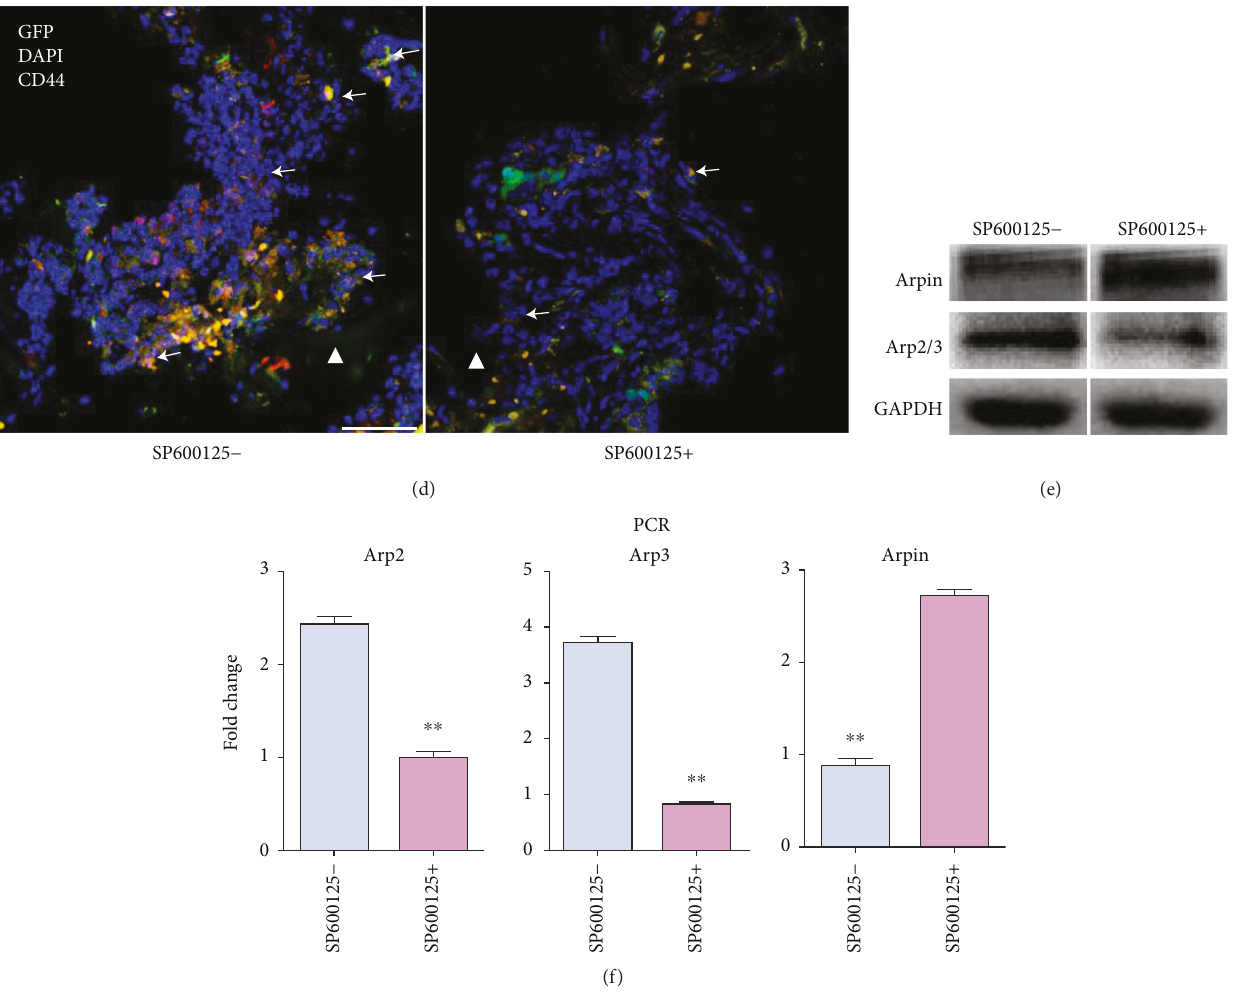
Figure 5: JNK served as an e ff ector downstream of SDF-1/CXCR4 in the migration of bone marrow (BM) CD44 + cells towards tissue- engineered constructs (TECs). (a) Comparison of phosphorylated JNK (p-JNK), ERK (p-ERK), and P38 (p-P38) expression in BM cells after CXCR4 blockade. After migration stopped, BM cells were collected and analyzed by western blot. (b) Representative images of cell migration towards SDF-1. The quanti fi cation of migrated BM cells is shown as a bar graph ( n = 5 ). ∗∗ P < 0 01 . (c) FACS analysis of the proportions of CD44 + cells in peripheral blood (PB). The quanti fi cation comparison is shown as a bar graph ( n = 3 ). ∗∗ P < 0 01 . (d) Representative images of in vivo migration of GFP + /CD44 + cells towards TECs. The introduction of SP600125 signi fi cantly reduced the recruitment of GFP + /CD44 + cells. White triangle, implant area; white arrows, CD44 + cells; scale bar, 50mm. (e) Comparison of Arpin and Arp2/3 expressions in BM cells after JNK blockade in vitro . (f) Analysis of the Arpin, Arp2, and Arp3 mRNA expression in sorted CD44 + cells. On day 3 postoperatively, cells in PB were sorted by FACS on CD44. RT-PCR was performed to evaluate Arpin, Arp2, and Arp3 mRNA expression. The quanti fi cation data are shown as a bar graph ( n = 3 ). ∗∗ P < 0 01